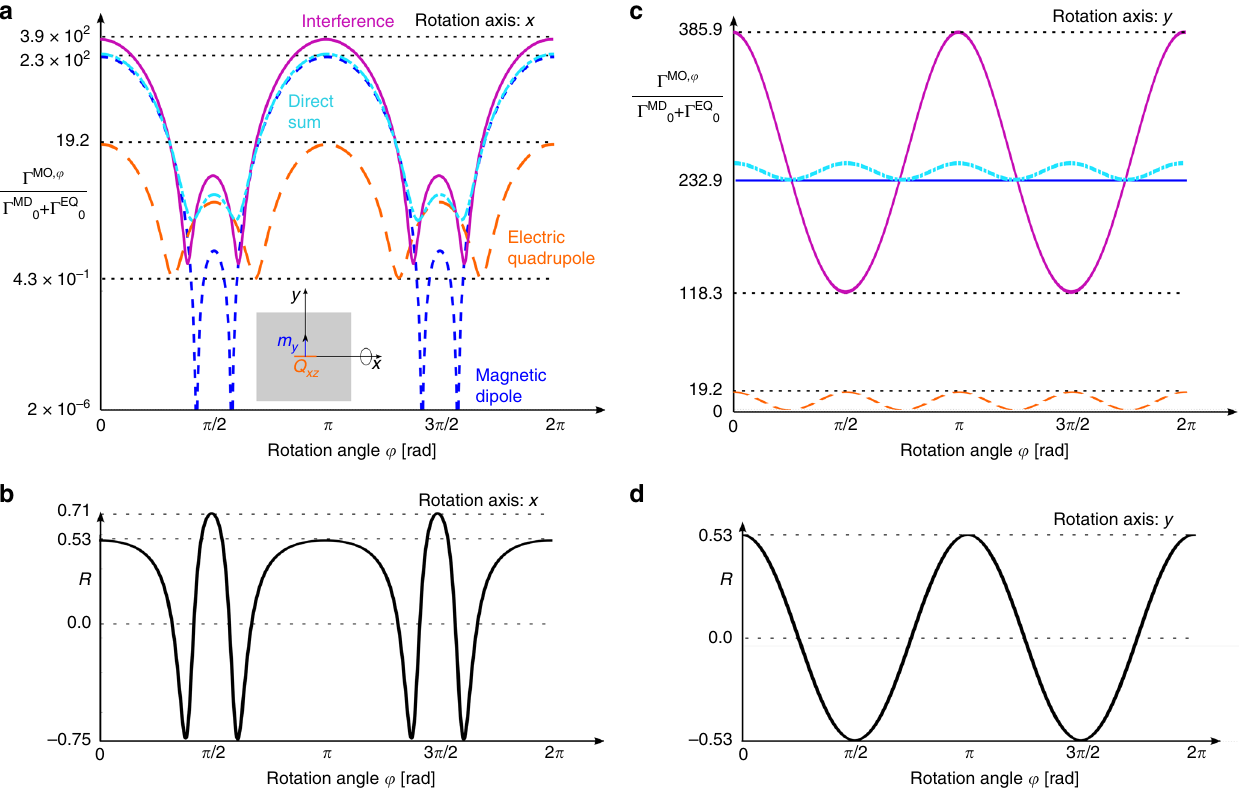
Fig. 3 Calculated transition rates and R parameters . Transition characteristics due to different multipolar mechanisms of a model OsO 3 molecule positioned in the center of the nanoantenna are shown in function of rotation angle with respect to x ( a and b ) or y axis ( c and d ). Original orientation of multipolar moments of transition 1 is depicted in the inset of panel ( a ). a Transition rates between the ground state 0 and excited state j = 1. The magnetic dipole Γ MD ; φ and electric quadrupole Γ EQ ; φ contributions are shown with dotted blue and dashed orange lines, respectively. The total transition rate Γ (magenta solid line) includes the interference between the two contributing mechanisms, and may differ from their direct sum Γ MD ; φ þ Γ EQ ; φ (cyan dash- dotted line). b Figure of merit R indicating the respective role of the interference terms for the full transition rate shown in ( a ). c , d As in panels ( a ), ( b ), but for rotations of the molecule around the y axis of the coordinate